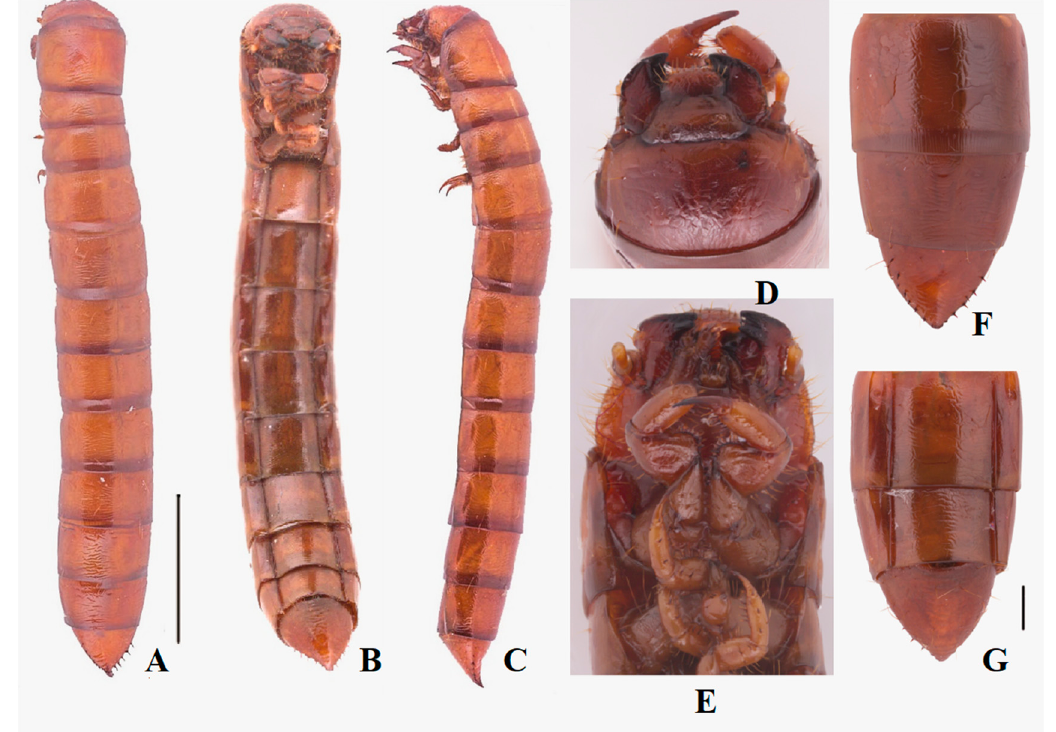
Figure 5. Larva of Nalepa quadrata Li & Ren sp. n. ( A – C ). Habitus: ( A ). dorsal view; ( B ). ventral view; ( C ). lateral view. ( D ). Head, dorsal view; ( E ). Head and prothoracic leg, ventral view; ( F ). Pygopods, dorsal view; ( G ). Pygopods, ventral view. Scale bars: 5 mm ( A – C ), 1 mm ( D – G ). Etymology. This species is named from the Latin adjective “ quadratus , -a , um ”, in ref- erence to its pronotum nearly square.